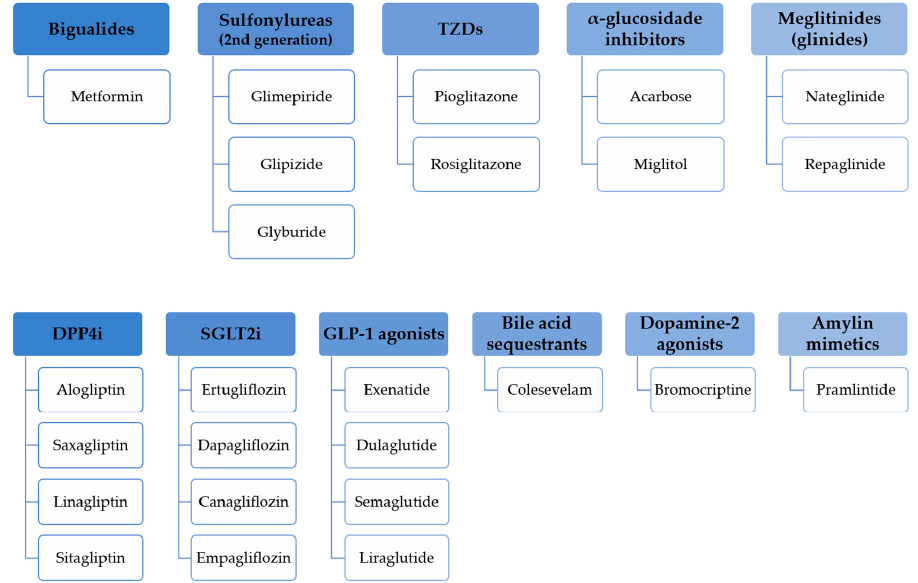
Figure 2. Oral and injectable non-insulin glucose-lowering drugs approved by the American Diabetes Association.